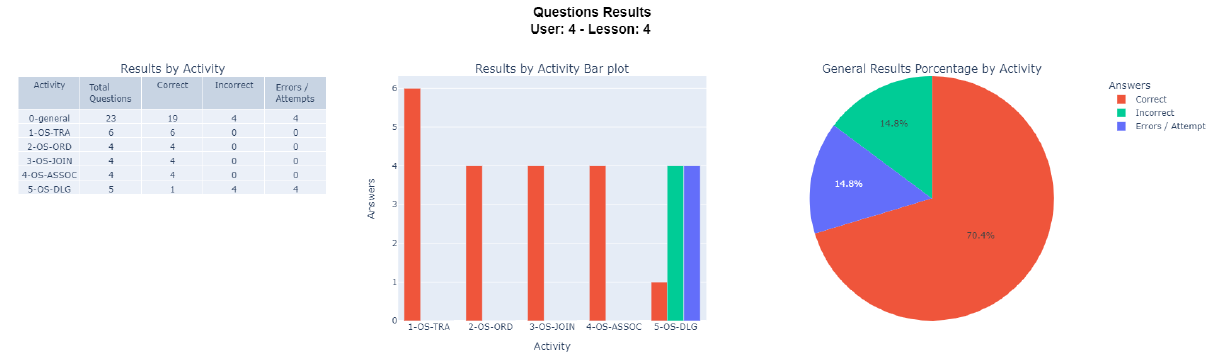
Figure 16. Visualization for question results.